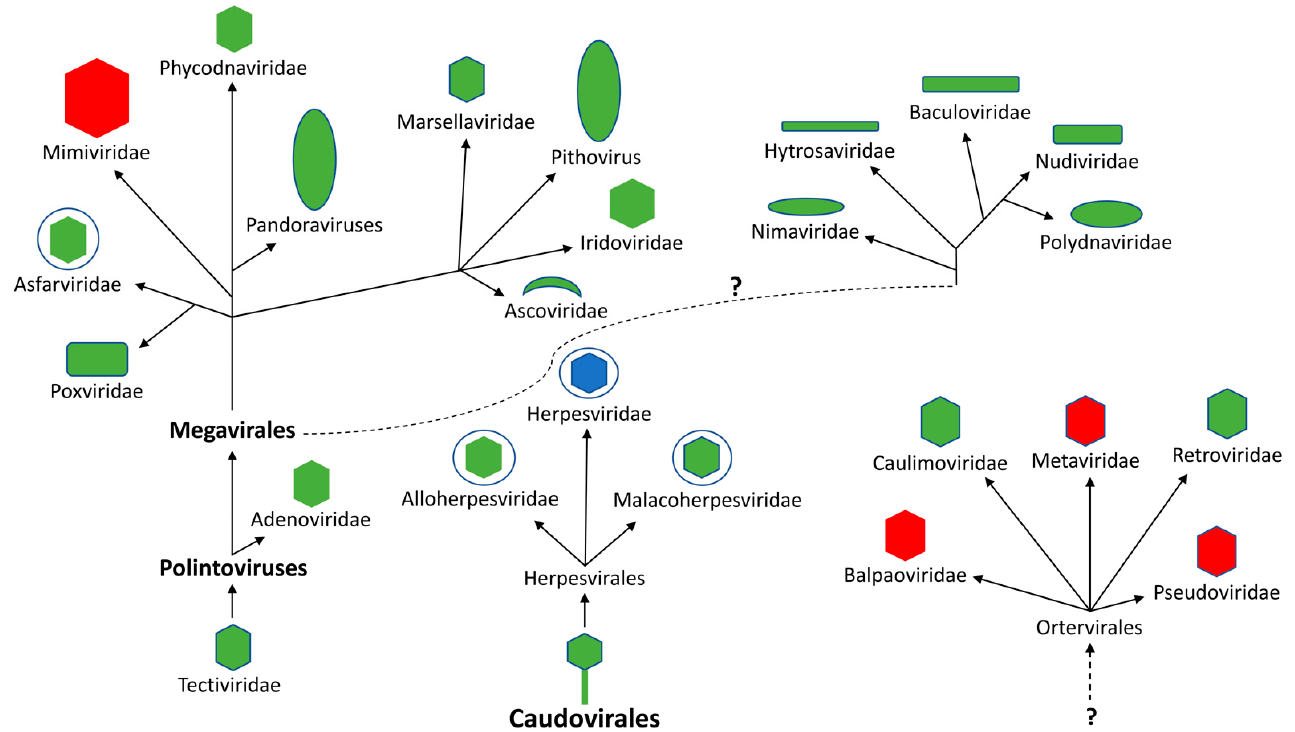
Figure 1. Evolutionary distribution of putative dUT genes in double-stranded DNA viruses and single-stranded RNA viruses that replicate through a DNA intermediate ( Ortervirales ). The DNA viruses are proposed to have evolved from two distinct groups of bacteriophages ( Tectiviridae and Caudovirales ) [15]. The dotted line with a question mark indicates an unknown evolutionary relationship. Red indicates that no members have been reported to possess putative dUT gene, green indicates that at least one member has been reported to contain a dUT gene encoding a homotrimeric protein, while blue indicates that a least one member contains a dUT gene encoding a monomeric protein.